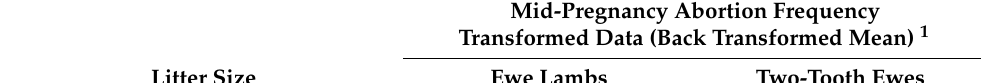
Table 4. Transformed and back-transformed means for frequency of mid-pregnancy abortion in maiden ewe lambs and Merino two-tooth ewes determined using a general linear mixed